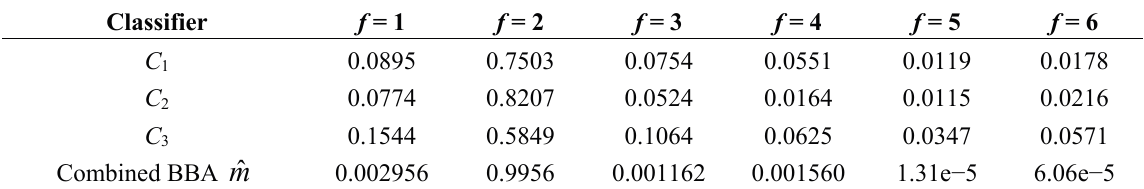
Table 6. Combination process of the outputs of three classifiers about one test sample of f =